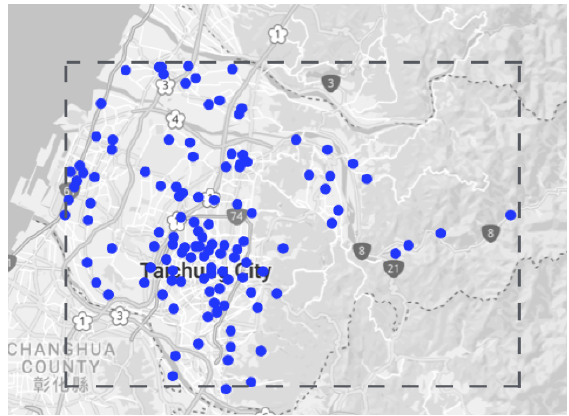
Figure 9. Geographical location of 132 monitoring